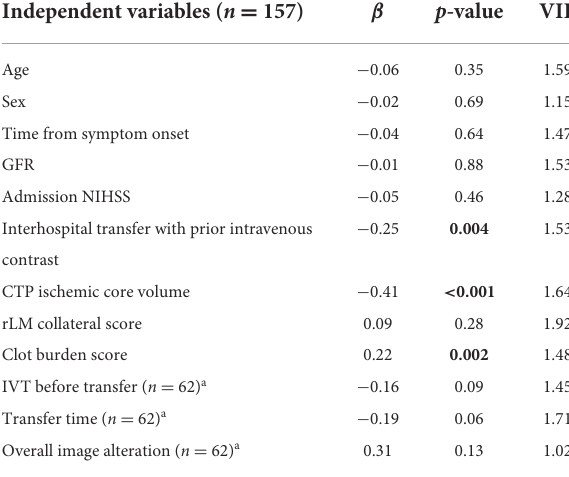
TABLE 3 Multivariate regression analysis for association of non-contrast CT ASPECTS at CSC arrival with clinical and imaging